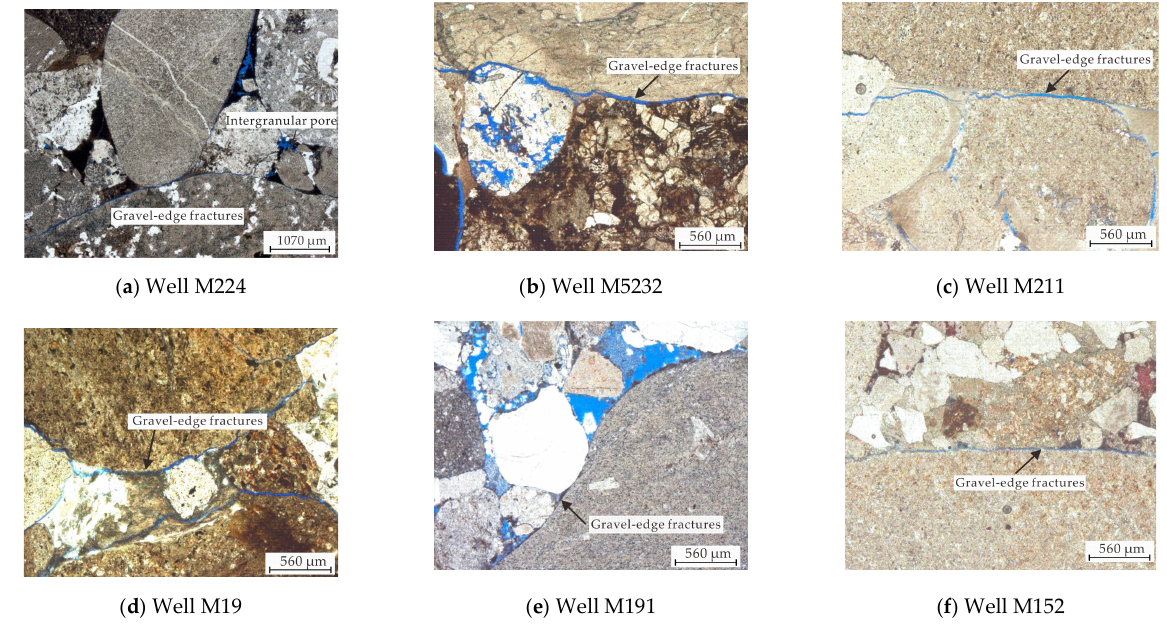
Figure 4. ( a–f ) Thin sections of core samples from drilled